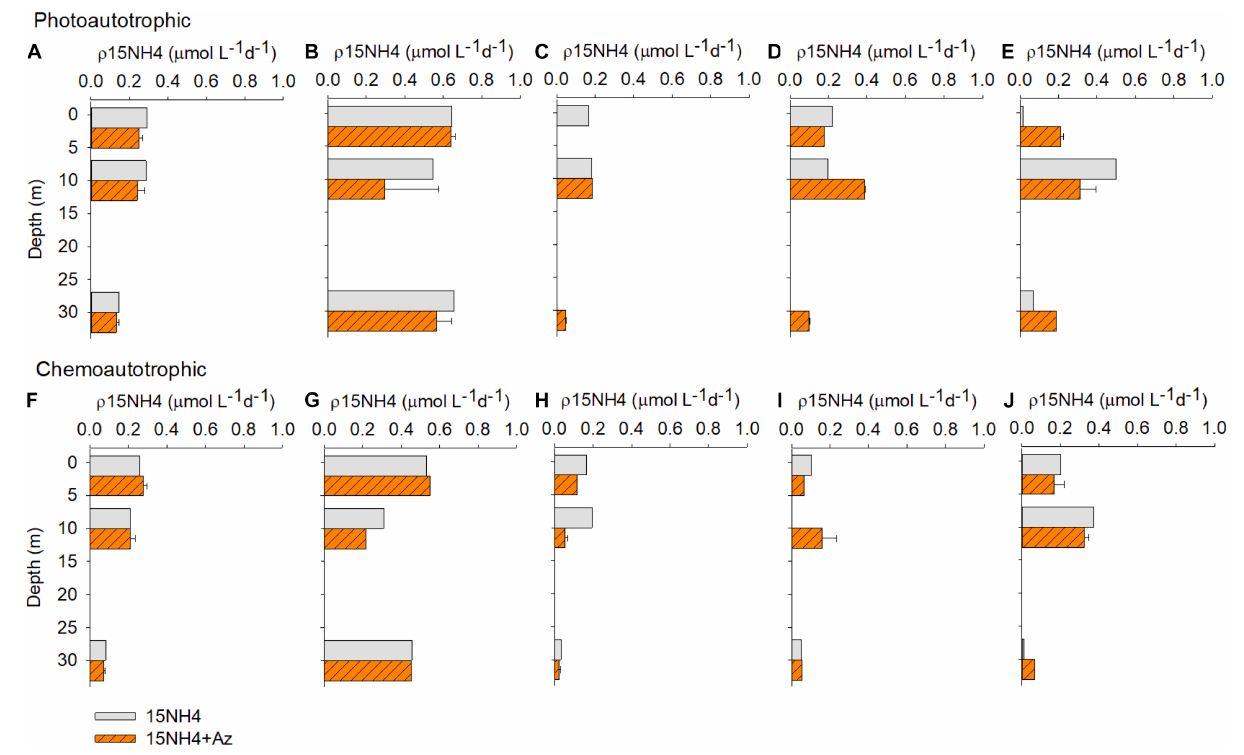
FIGURE 6 | In situ photoautotrophic (upper panel) and chemoautotrophic (lower panel) ammonium uptake rates ( µ mol L − 1 d − 1 ) during summer 2015. (A,F) Qc; (B,G) Q2; (C,H) Q3; (D,I) Q5; (E,J) Q9 station.